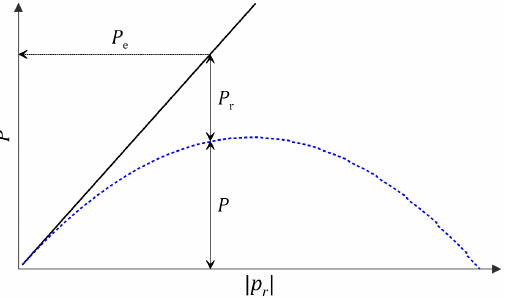
Figure 4. Concept of absorbed pneumatic power and its excitation and radiation component in the linear decomposition method.